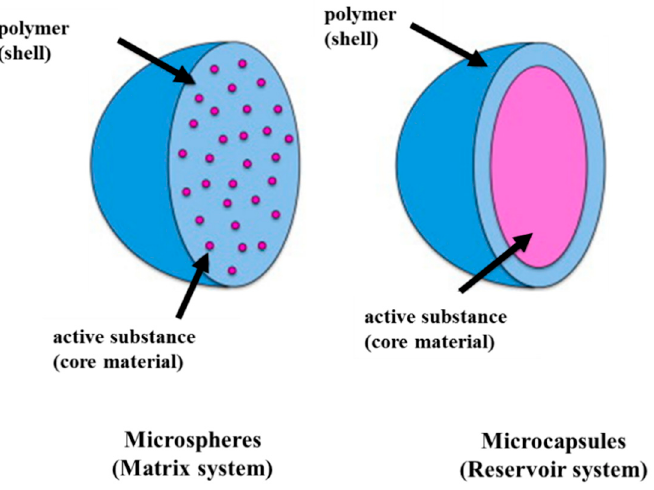
Figure 1. Schematic structure of microspheres and microcapsules (adapted from Paulo and Santos 2017